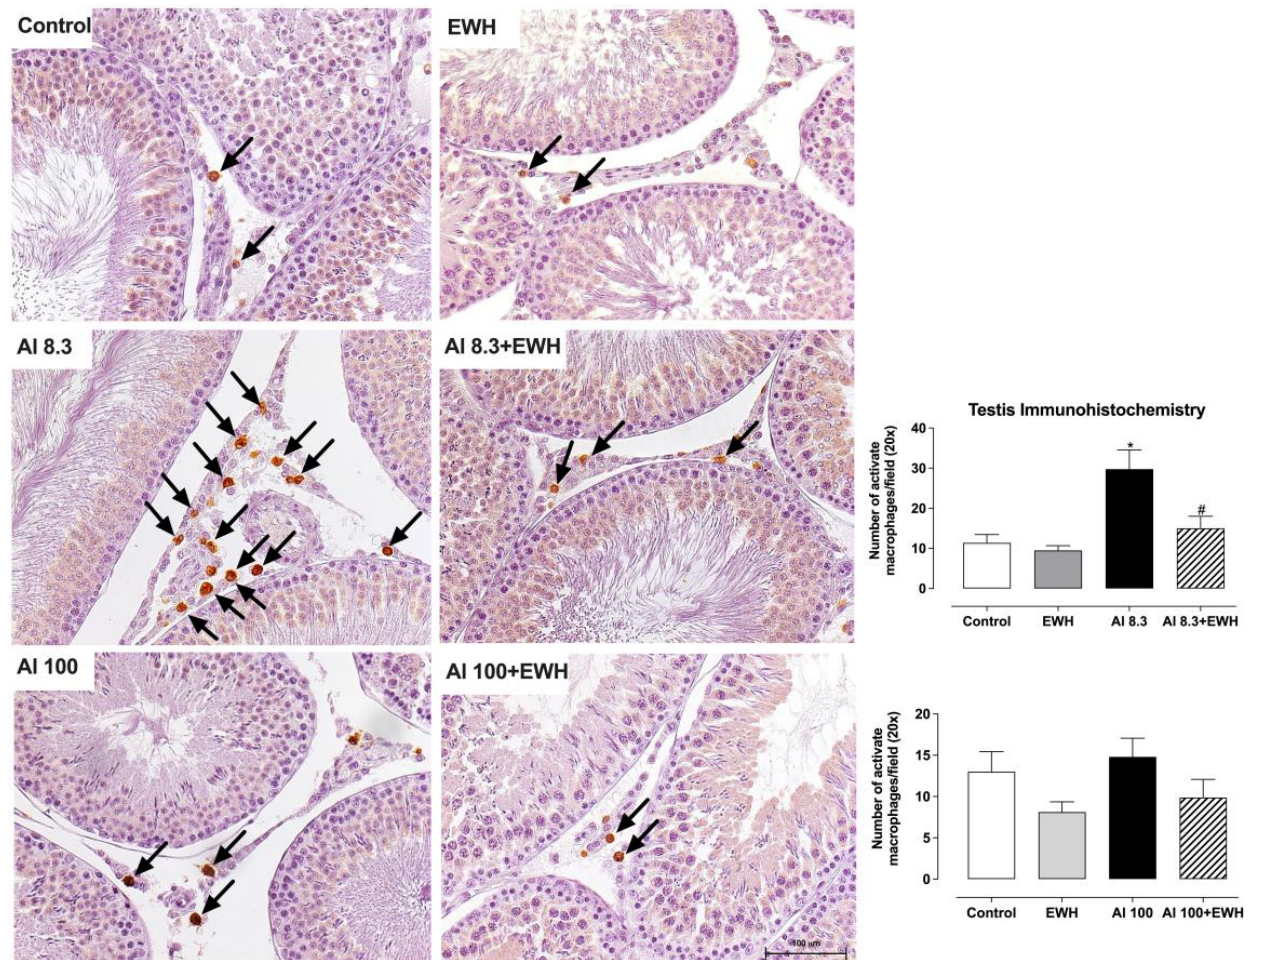
Figure 5. Effect of EWH on testis immunohistochemistry of rats exposed to AlCl 3 at 8.3 or 100 mg/Kg b.w. per day. Testis sections showing activated macrophages (arrows) detected by immunohistochem- istry. Scale bars: 100 µ m. Graphs: Average numbers of activated macrophages per field (objective 20 × ). Data are expressed as mean ± SEM, n = 6, * p < 0.05 compared with their corresponding controls, # p < 0.05 compared with AlCl 3 group (two-way ANOVA and Bonferroni as post-hoc